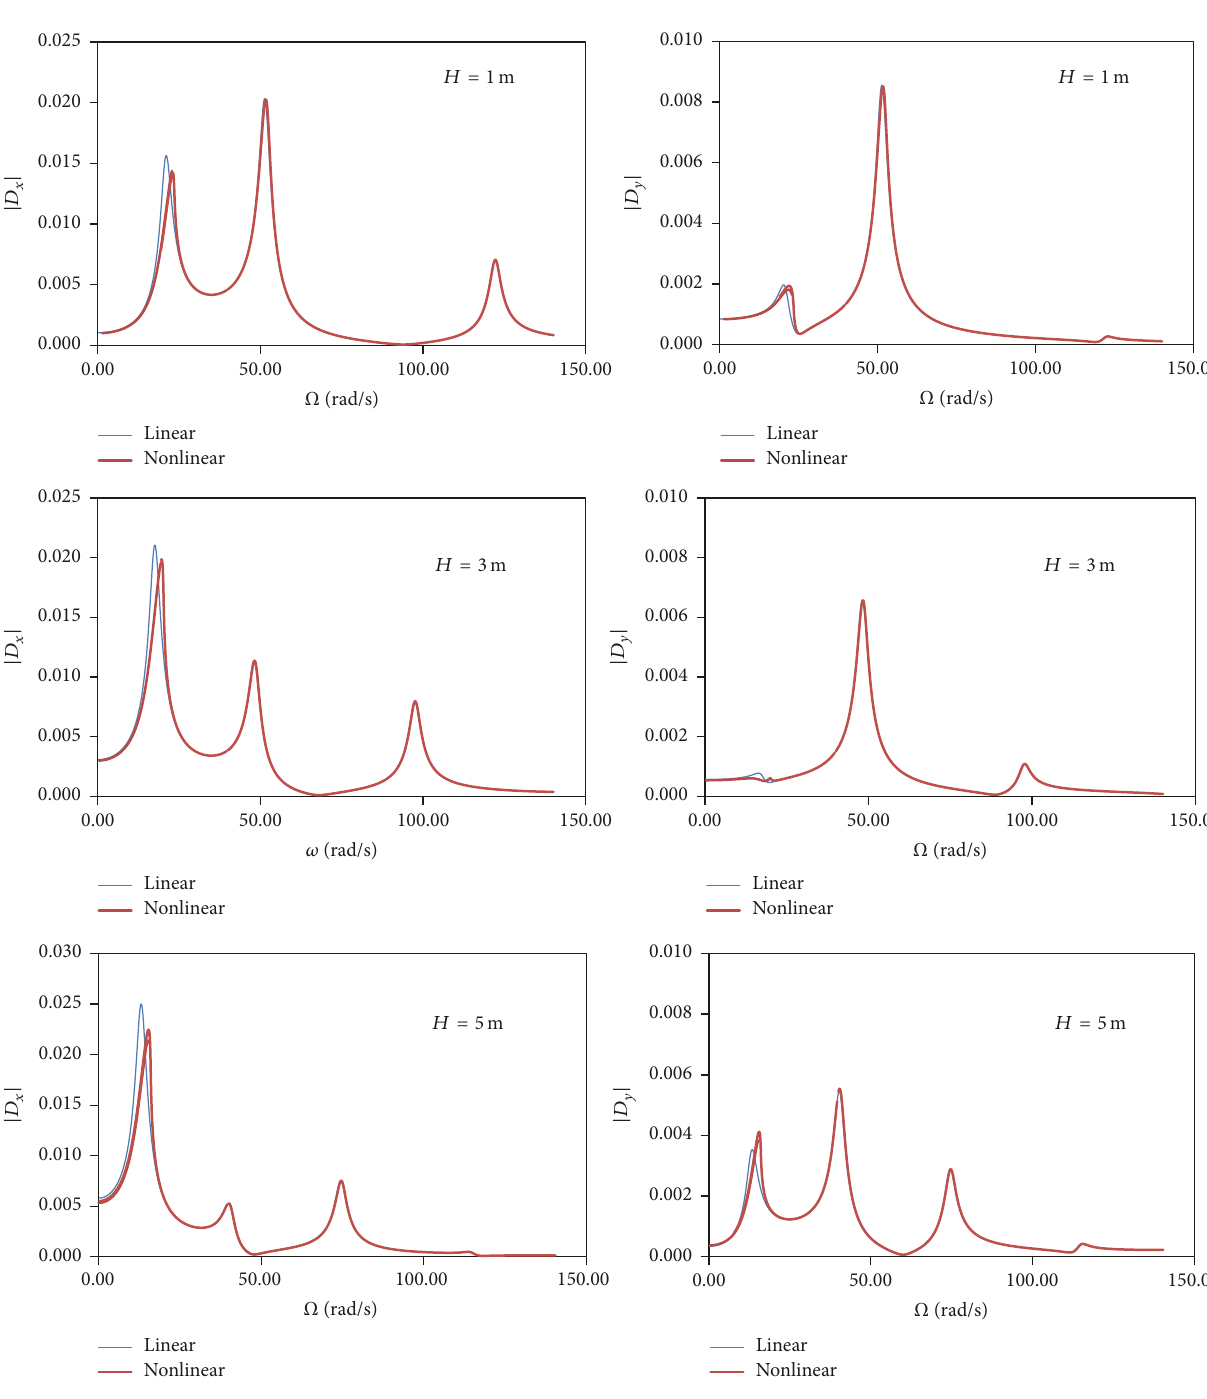
Figure 12: Variation of the norm of the vertical and horizontal vibration amplitudes at the roof top as a function of the excitation frequency for simultaneous vertical and horizontal excitation and three values of the roof height 𝐻 . 𝐴 𝑥 = 0.8𝑔 and 𝐴 𝑦 = 0.667𝐴 𝑥